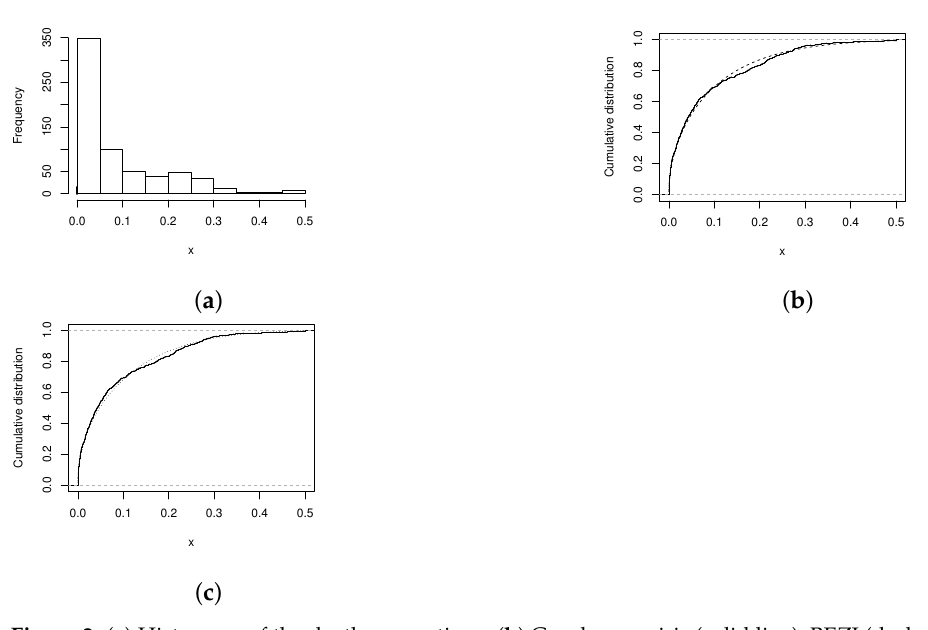
Figure 2. ( a ) Histogram of the death proportions. ( b ) Graphs: empiric (solid line), BEZI (dashed line). ( c ) Graphs: empiric (solid line), BUBSZI (dotted line). Table 3. The MLE of the parameters of the BEZI, Tobit and BUBSZI models. Est. BEZI Tobit